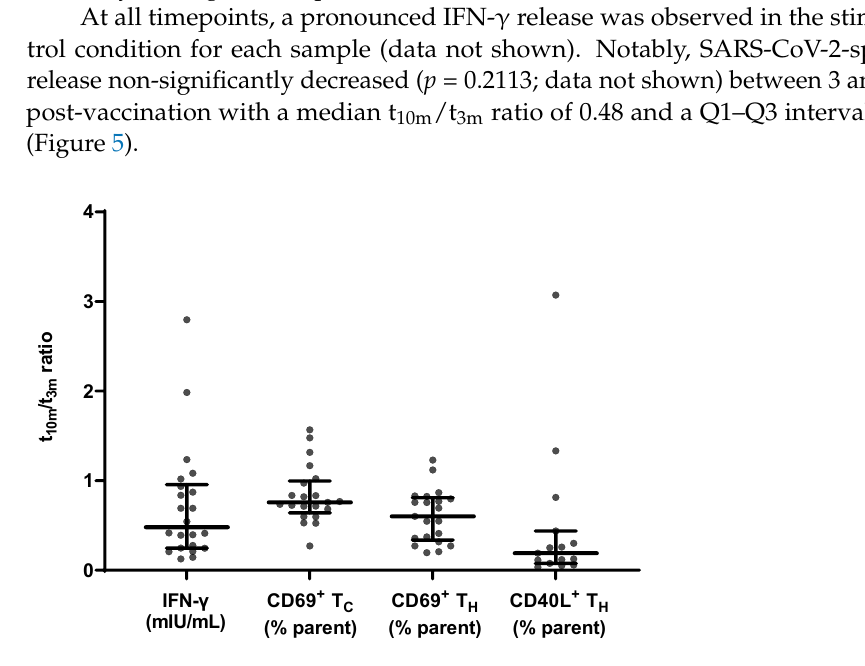
Figure 5. Evolution of SARS-CoV-2-specific cellular immune response parameters measured at mid- and long-term follow-up ( n = 21). From left to right: specific IFN- γ release ratio, CD69 membrane expression in T C cells ratio, CD69 membrane expression in T H cells ratio and CD40L membrane expression in T H cells ratio between t 10m and t 3m . Error bars represent median with IQR. IFN- γ = interferon γ , pre = baseline sampling moment before vaccination, 3m = 3 months after baseline, 10m = 10 months after baseline, IQR = interquartile range.